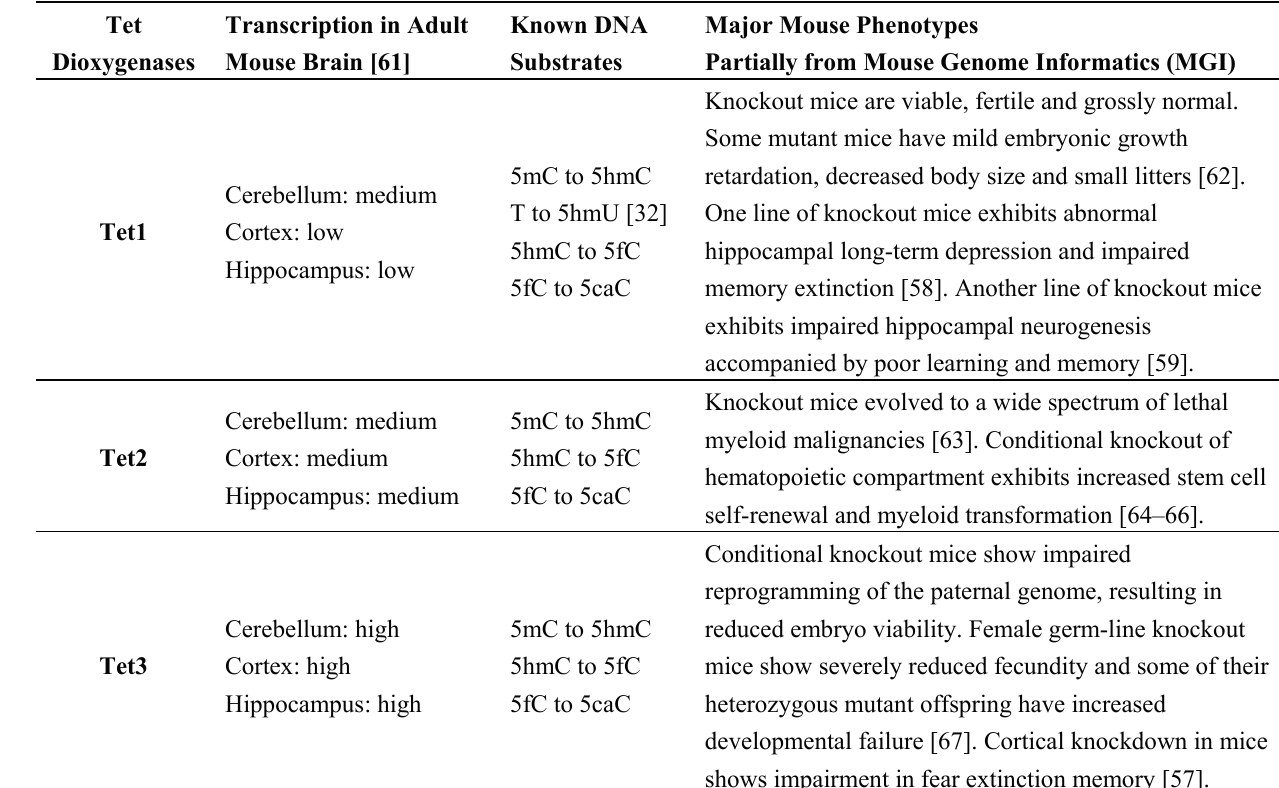
Table 1. Function of mouse TET methylcytosine